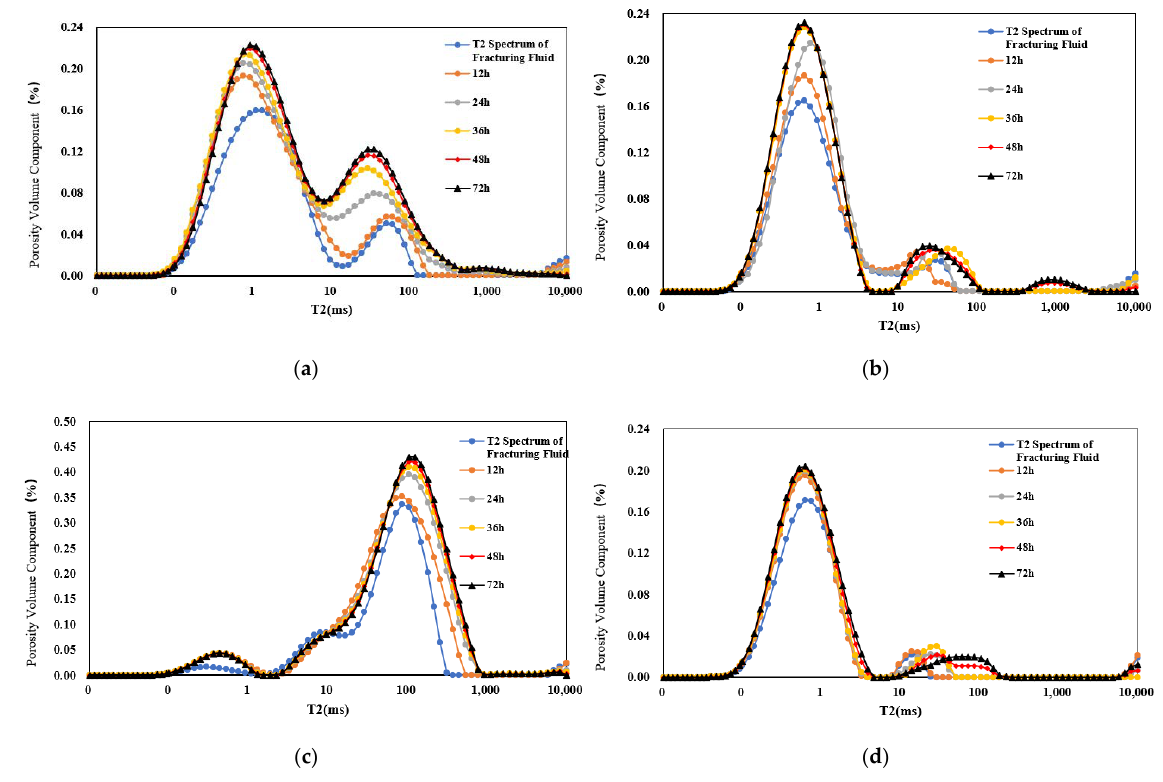
Figure 8. T2 spectra of different rock samples under different soaking periods. ( a ) Rock sample 1; ( b ) Rock sample 2; ( c ) Rock sample 3; ( d ) Rock sample 4.